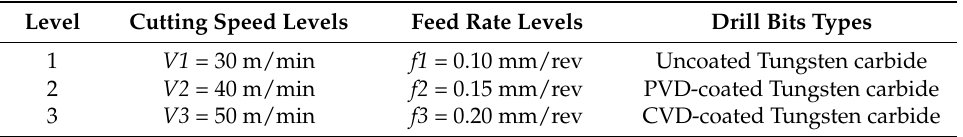
Table 2. Cutting parameters and levels.